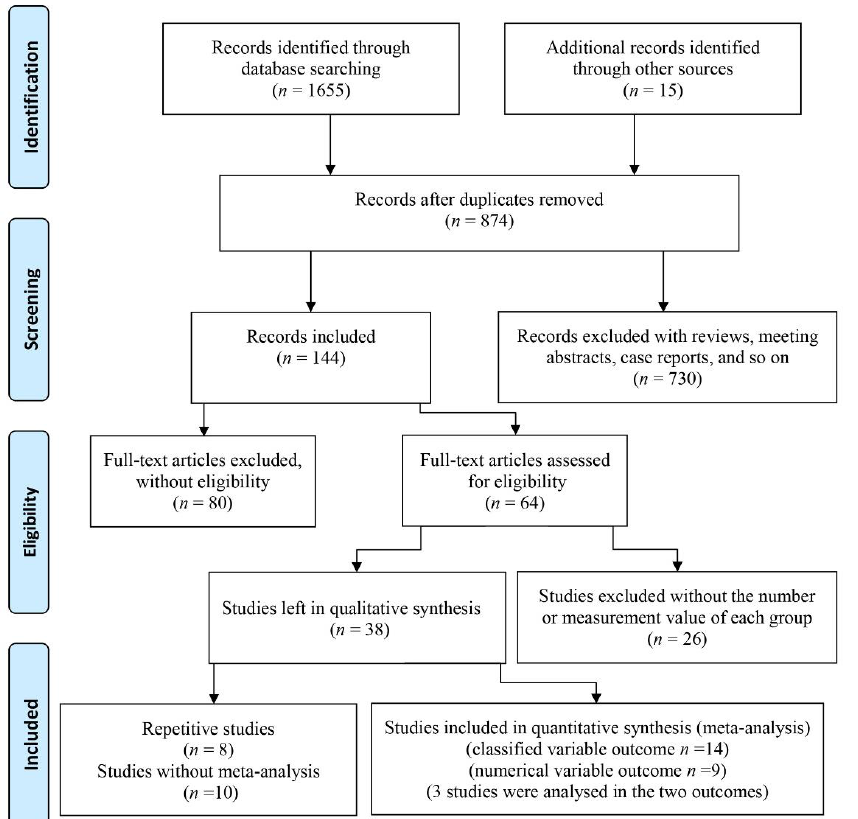
Figure 1. Flow diagram of study selection.